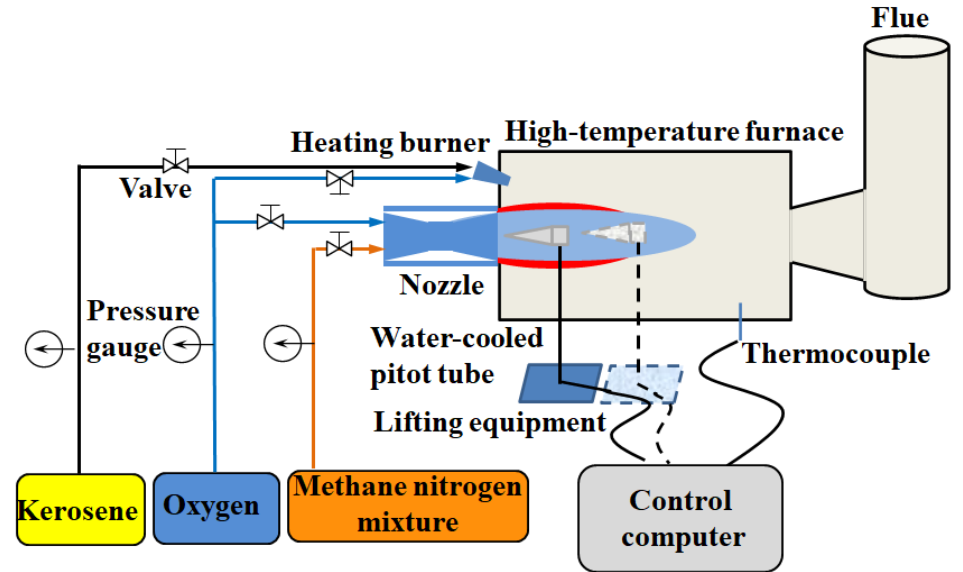
Figure 2. Schematic of the experimental apparatus.